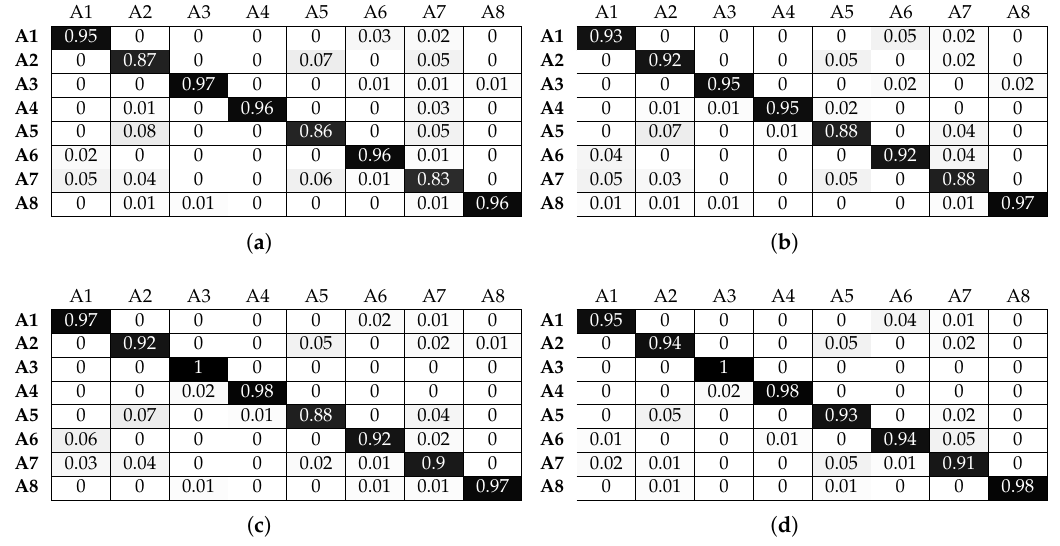
Figure 15. Normalised confusion matrices for random forest, with Wearable Feature Type 2, with beacon data. ( a ) n = 48, w = 1 s; ( b ) n = 46, w = 2 s ; ( c ) n = 42, w = 3 s; ( d ) n = 41, w = 4 s.